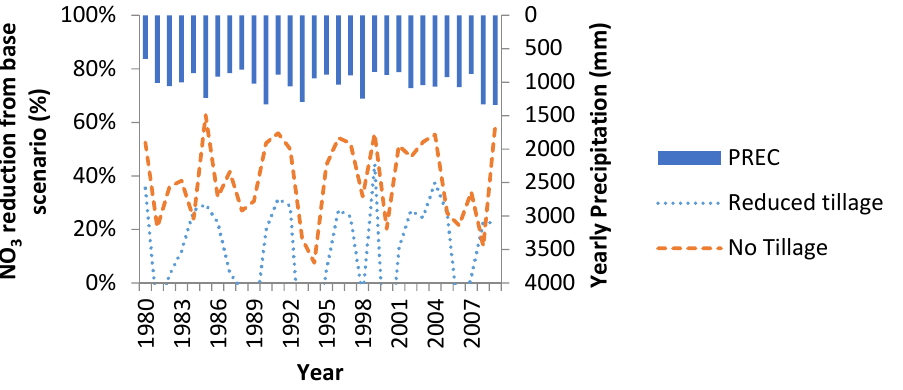
Figure 6. Nitrate load reduction in outlet flow for different tillage practices compared to conventional